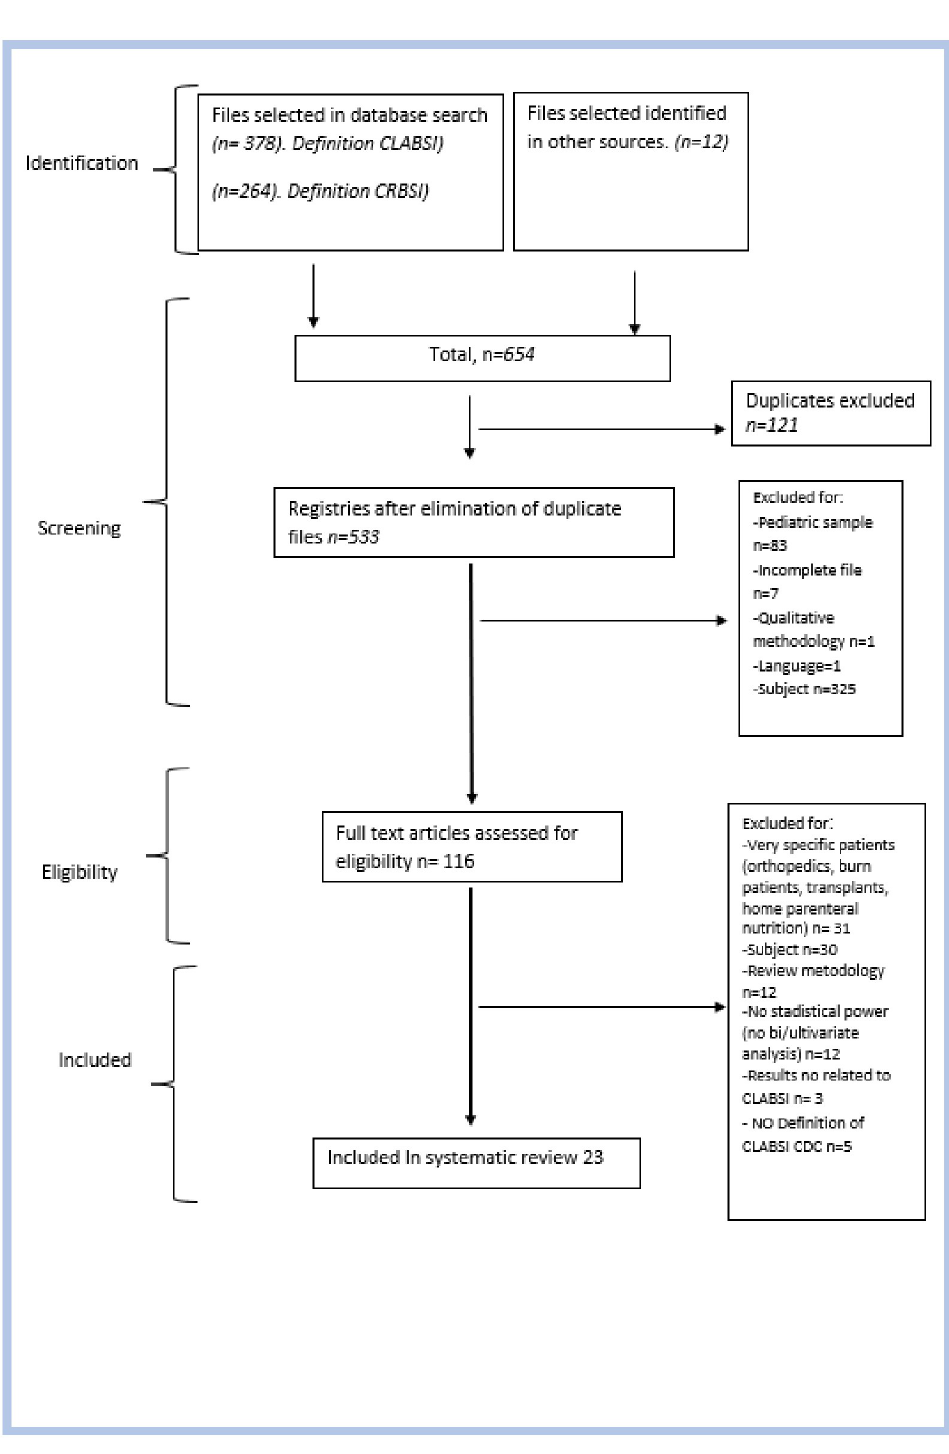
Fig 1. Flow diagram of study